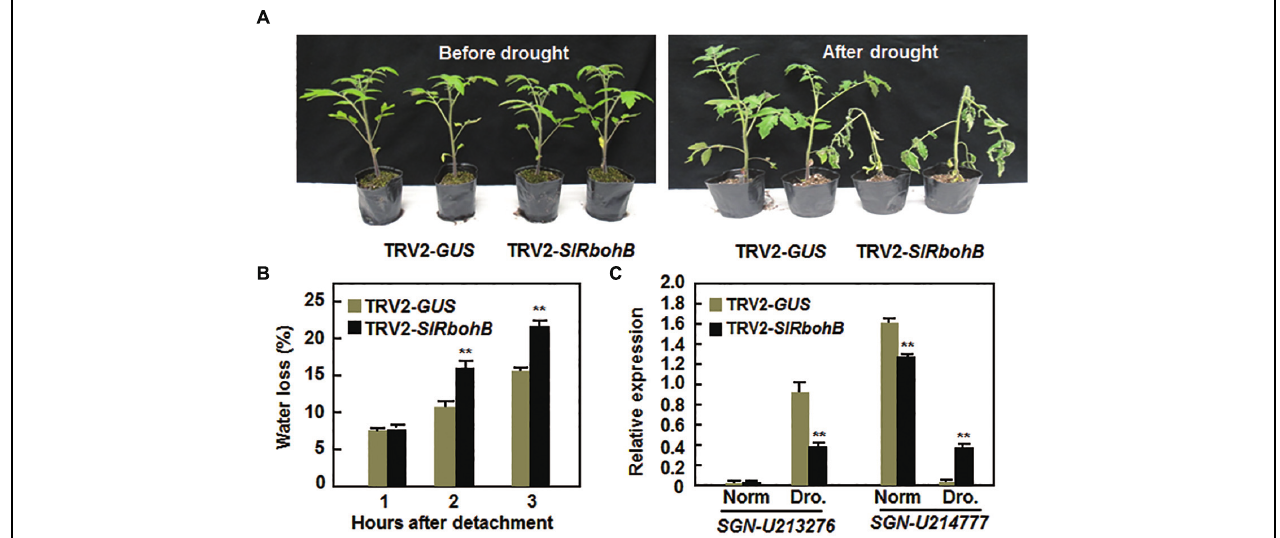
FIGURE 8 | Silencing of SlRbohB led to reduced drought tolerance. Two-week-old plants were infiltrated with agrobacteria harboring TRV2- SlRbohB or TRV2- GUS and the TRV2- SlRbohB - and TRV2- GUS -infiltrated plants were subjected to drought assays at 4 weeks after agroinfiltration. (A) Growth performance of the TRV2- SlRbohB - and TRV2- GUS -infiltrated plants under normal watering conditions (left) and at 10 days after drought stress treatment by withholding watering (right). (B) Rates of water loss in detached leaves of the